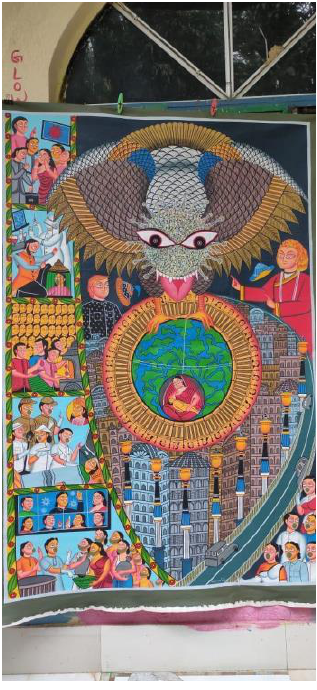
Figure 4. Anwar Chitrakar, “Coronavirus”. ICCR Award-winning Scroll without Song Acknowledgments to Anwar Chitrakar.